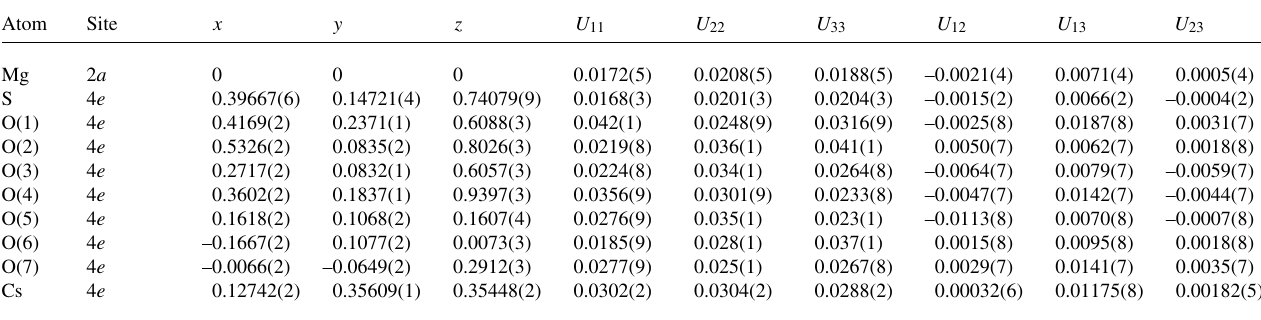
Table 3. Atomic coordinates and displacement parameters (in Å 2 ) .